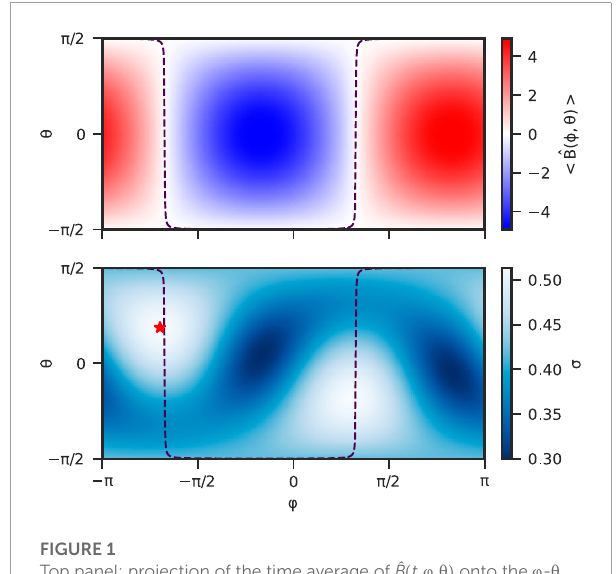
FIGURE 1 Top panel: projection of the time average of ̂ B ( t , φ , θ ) onto the φ - θ plane, and bottom panel: projection of the normalized standard deviation, σ (see the text for the definition of σ ). The dashed line indicates the direction perpendicular to the mean magnetic field. The star symbol corresponds to the maximum σ